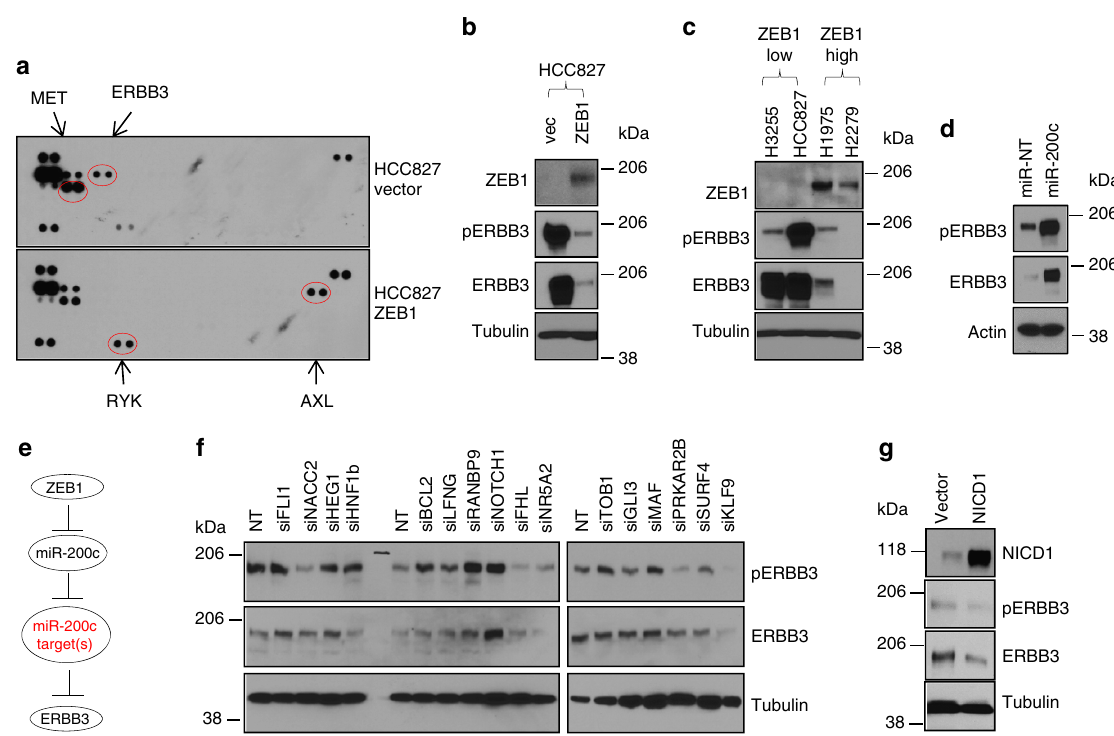
Figure 3 | ZEB1 suppresses ERBB3 through miR-200c targets. ( a ) Phospho-receptor tyrosine kinase (RTK) array for HCC827 expressing ZEB1 or an empty pcDNA3.1 vector. ( b ) Western blotting of ZEB1, phospho-ERBB3 (pERBB3), ERBB3 and Tubulin for HCC827 cells expressing ZEB1 or the pcDNA3.1 vector. ( c ) Western blotting of ZEB1, pERBB3, ERBB3 and Tubulin for a panel of four EGFR -mutated human lung cancer cell lines. ( d ) miR-200c increased both pERBB3 and ERBB3. ( e ) Schematic for hypothetical role of miR-200c targets in ERBB3 inhibition. ( f ) The effect of individual knockdown of miR-200c targets on the expression and phosphorylation of ERBB3 in HCC827 cells expressing ZEB1. ( g ) Western blotting of NICD1, pERBB3, ERBB3 and Tubulin for H4006 cells transiently transfected with NICD1 or an empty vector